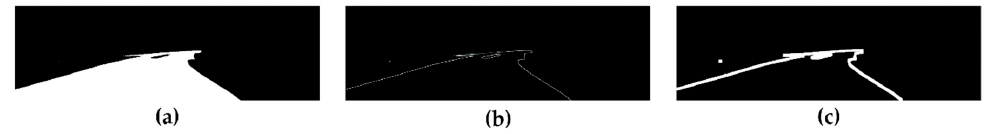
Figure 6. Visualization of the road edge region. ( a ) The road segmentation label; ( b ) road edge obtained from (a) by the Canny algorithm; ( c ) road edge region with a width of 10 pixels.